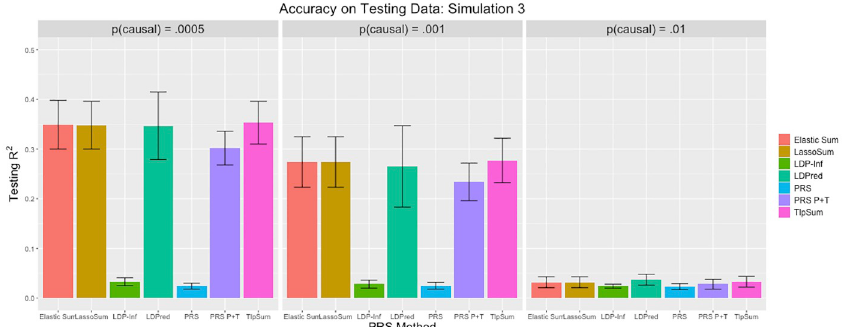
Fig 3. Prediction r 2 values for simulation 3. Error bars represent standard deviation for the r 2 value across 20 replications.